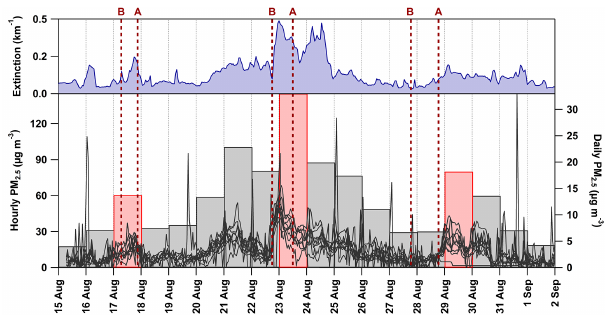
Figure 3. Top panel shows atmospheric extinction measured at the CDPHE DESCI site (see Fig. 1). Bottom panel shows hourly and daily averaged PM 2 . 5 mass concentrations at CDPHE sites. The pairs of red dashed lines shows the times before (“B”) and after (“A”) cold-frontal passages at BAO during or prior to each haze event. The daily averaged PM 2 . 5 in red represents the haziest days during or following cold-frontal passages (i.e., events 1, 2, and 3 on 17, 23, and 29 August 2015,